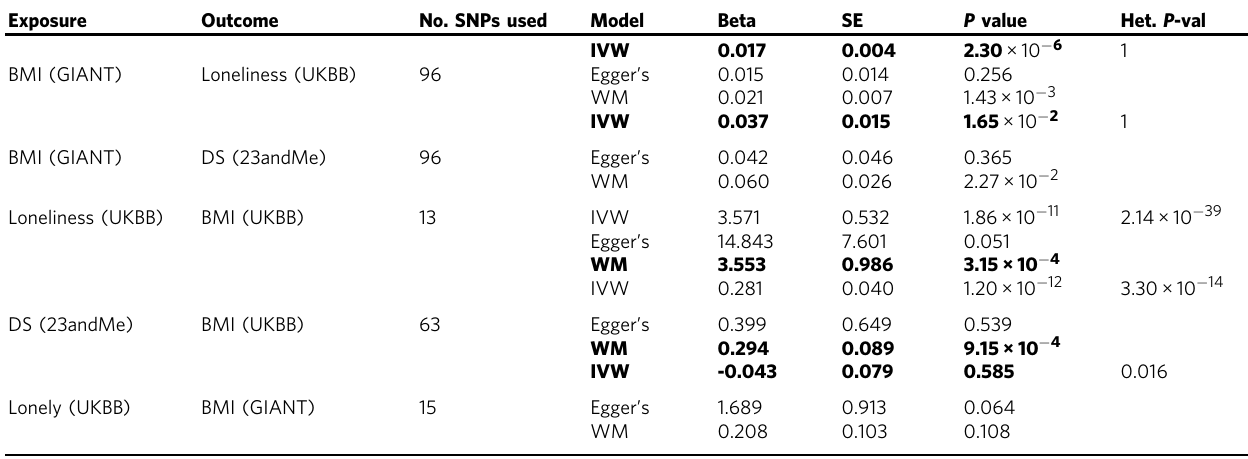
Table 1 Mendelian randomisation results